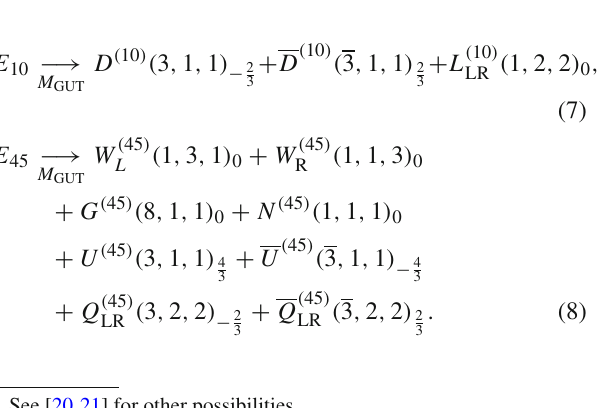
Table 1 The Yukawa interactions which come from the higher-dimensional operators in Eq.(5)